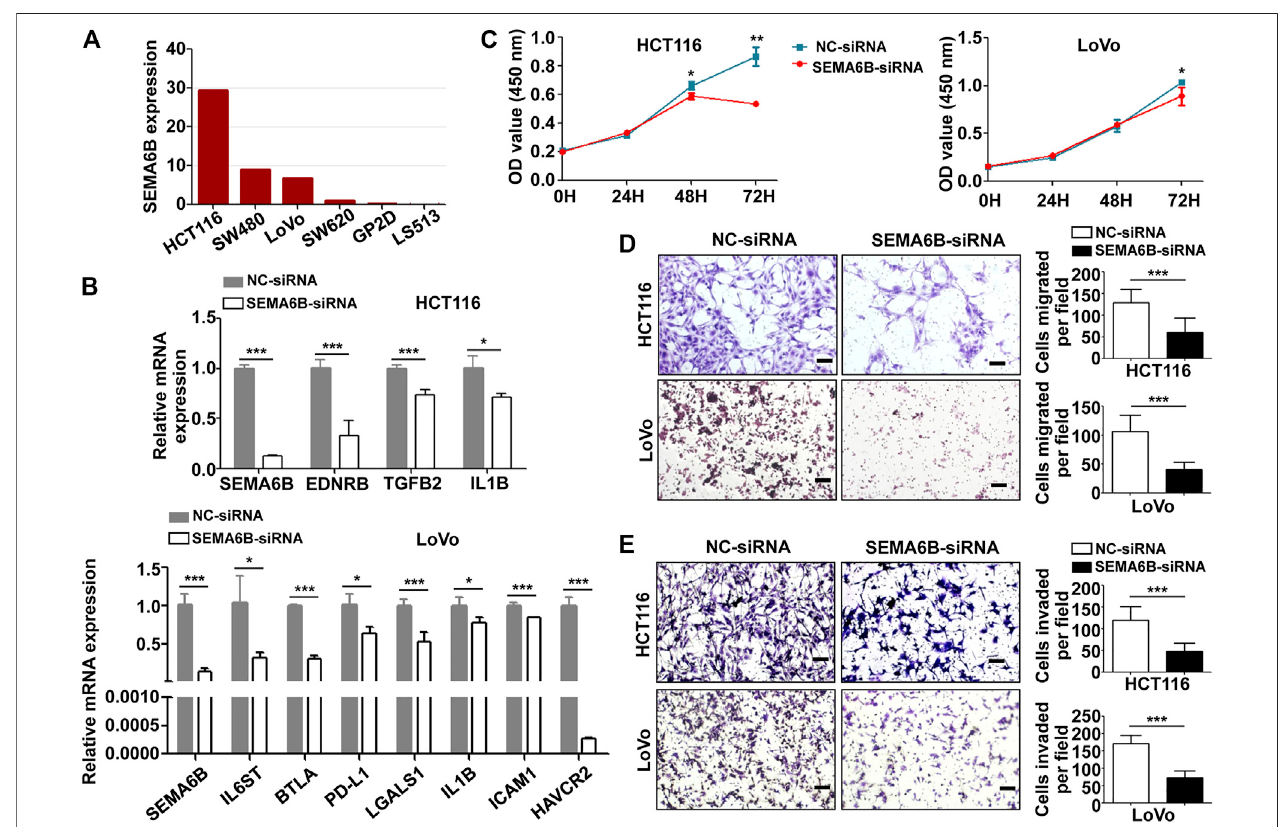
FIGURE 10 | SEMA6B knockdown retards the malignant biological behavior of colon cancer cells and the expression of immunosuppressive molecules. HCT116 andLoVocellsweretransfectedwithNC-siRNA orSEMA6B-siRNA. (A) ThemRNAexpressionlevelindifferentcoloncancercellsfromtheCCLEwebsite. (B) QRT-PCR analysis was performed to examine the knockdown ef fi ciency of SEMA6B and the relative mRNA expression of immunosuppressive genes. (C) CCK-8 assay was applied to evaluate cell viability. Transwell assay was employed to count the number of migrated (D) and invaded (E) cells. * p < 0.05, ** p < 0.01, and *** p < 0.001.